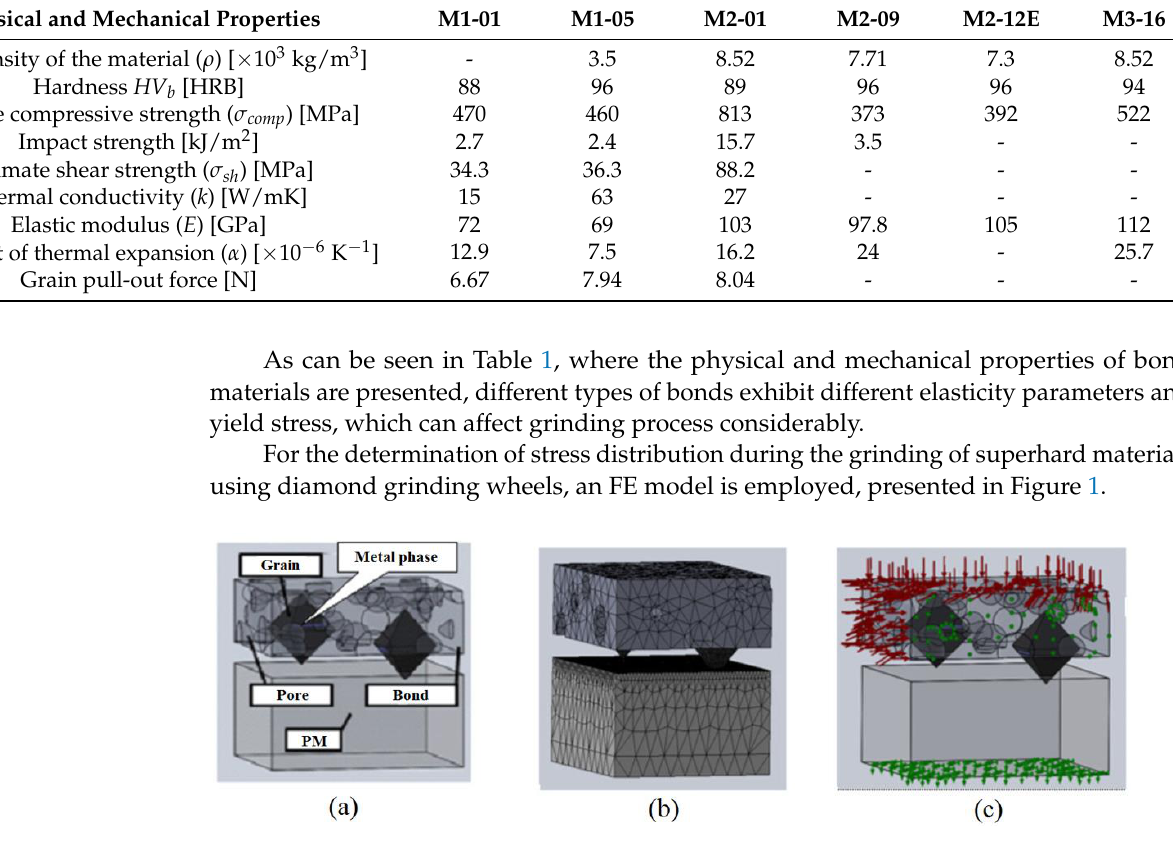
Table 1. Material composition of bond types used in the models.